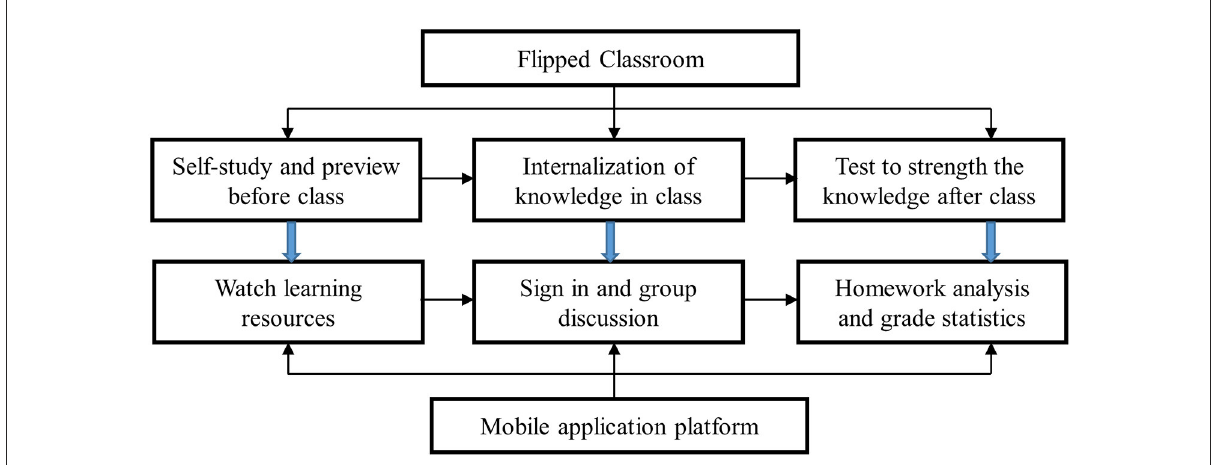
FIGURE2 Design of the flipped classroom teaching mode based on mobile